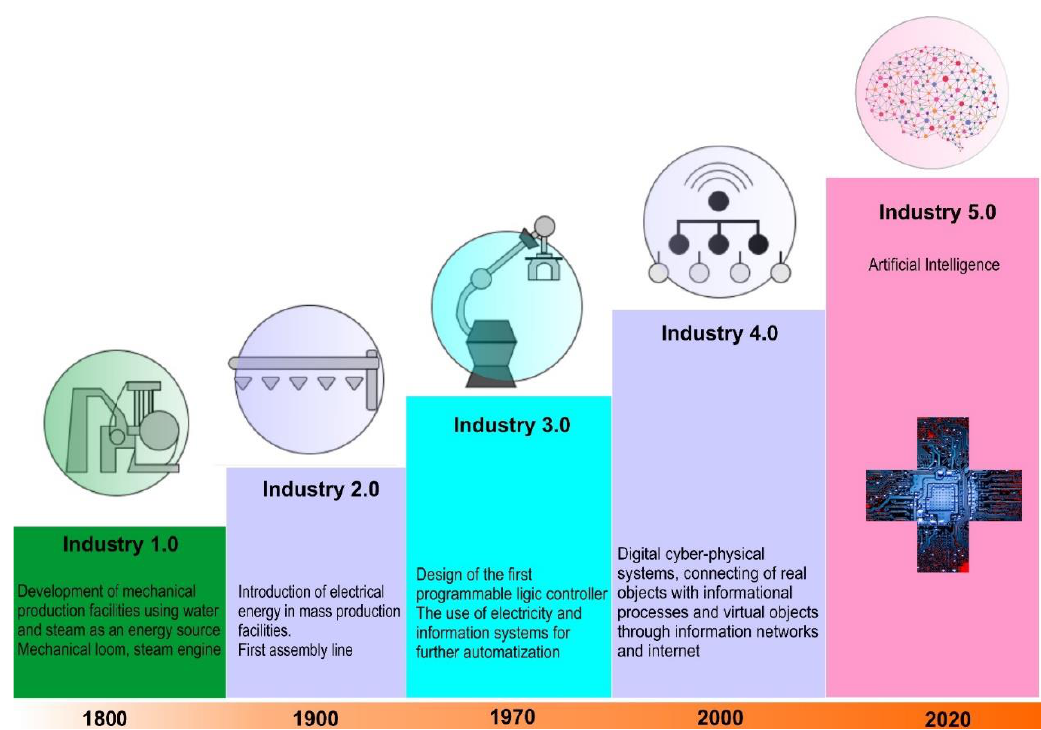
Figure 1. Evolution of industrial developments over time.